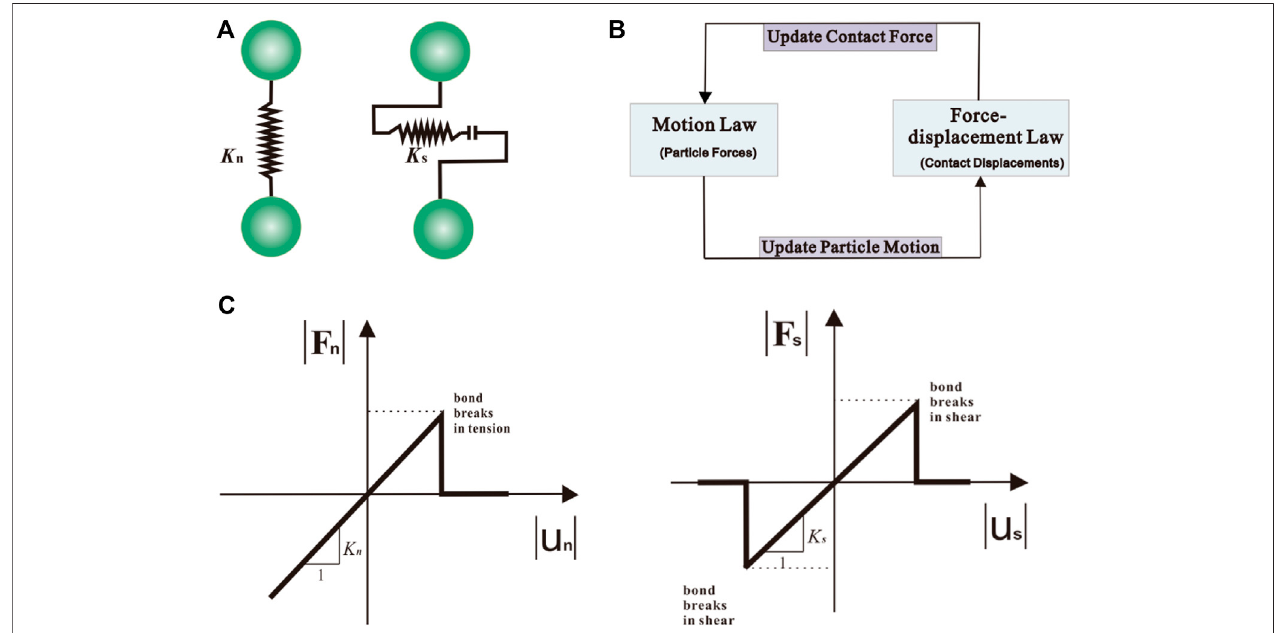
FIGURE 2 | Baecher model for crack characterization. (A) 3D Baecher disk. (B) 2D simpli fi cation.